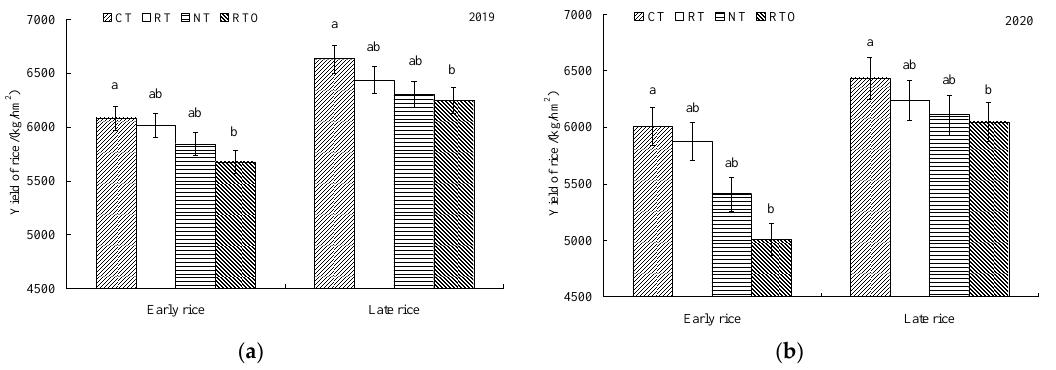
Figure 2. Impacts of different short-term tillage managements on early rice and late rice yield under the double-cropping rice system. CT: conventional tillage with crop residue incorporation; RT: rotary tillage with crop residue incorporation; NT: no-tillage with crop residue retention; RTO: rotary tillage with all crop residues removed as a control. Error bars represent standard error of the mean. Different lowercase letters indicated a significant difference at the 0.05 level. The same as below. ( a ) was the 2019, ( b ) was the 2020.